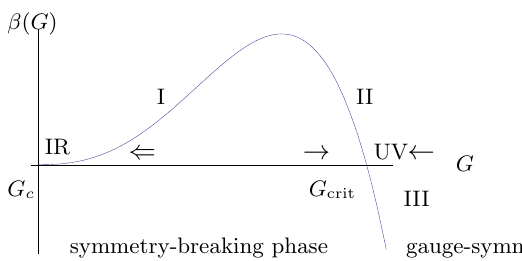
Figure 1 . This is a sketch [20] to qualitatively show the behavior of the β -function in terms of the four-fermion coupling G . We indicate the IR-stable fixed point G c and a possible UV-stable fixed point G crit , the latter separates the symmetry-breaking phase (positive β ( G )-function) from the gauge-symmetric phase (negative β ( G )-function). We also indicate the different parts of β ( G )- function: the positively increasing part “I” and the IR-domain where RG flow approaches (thick left arrow) to the IR-fixed point, as energy scale µ decreases; (ii) the positively decreasing part “II” and the negative part “III”, as well as the UV-domain where RG flow approaches (thin right and left arrows) to the UV-fixed point, as the running energy scale µ